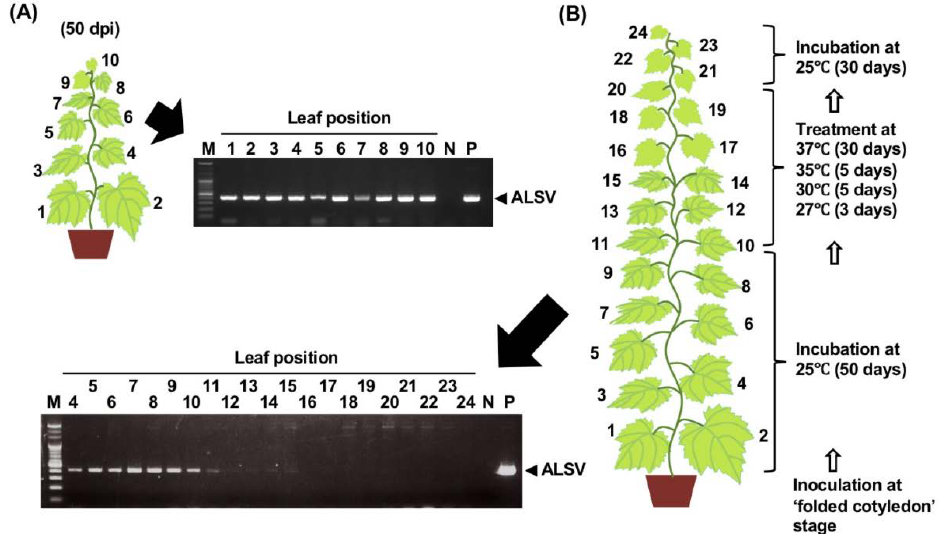
Figure 8. RT-PCR detection of ALSV in F 1 hybrid G × N seedlings before and after high-temperature treatment. ( A ) ALSV infection in inoculated seedlings was assayed by RT-PCR at 50 dpi. ( B ) Infected plants were incubated at 27 °C for 3 days, 30 °C for 5 days, 35 °C for 5 days, and then 37 °C for 30 days. The seedlings were then grown at 25 °C for 30 days and all expanded leaves were analyzed by RT-PCR to assess ALSV infection. Numbers indicate the leaf position on a grapevine seedling. M, size maker; N, negative control (non-infected tissue); P, positive control (infected tissue).